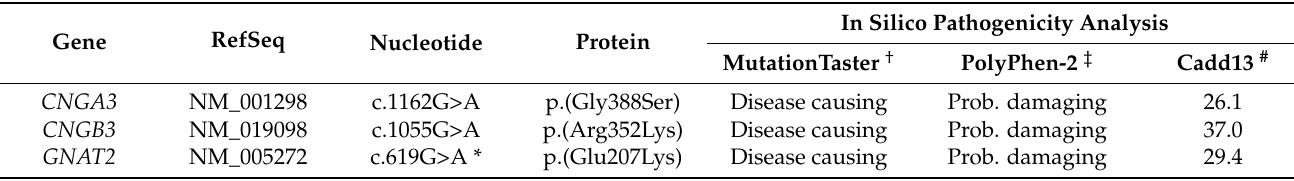
Table 3. Pathogenicity predictions for the novel missense variants reported in this study.